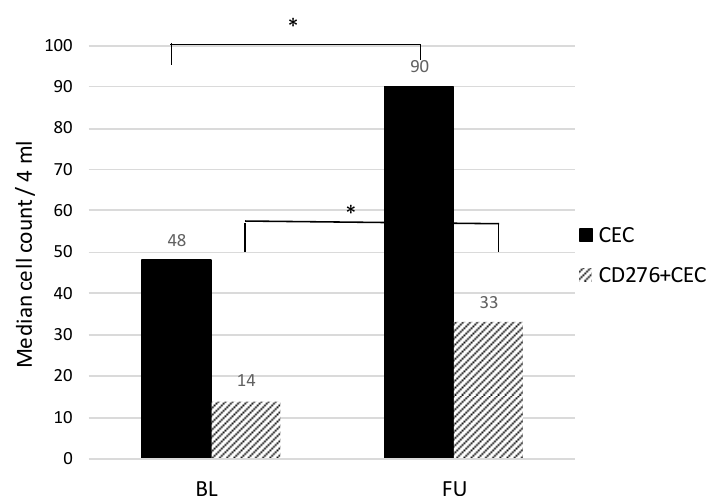
Figure 3. (CD276 + )CEC dynamics. CEC and CD276 + CEC counts per 4 mL in baseline and follow up blood samples. * Significant p value.